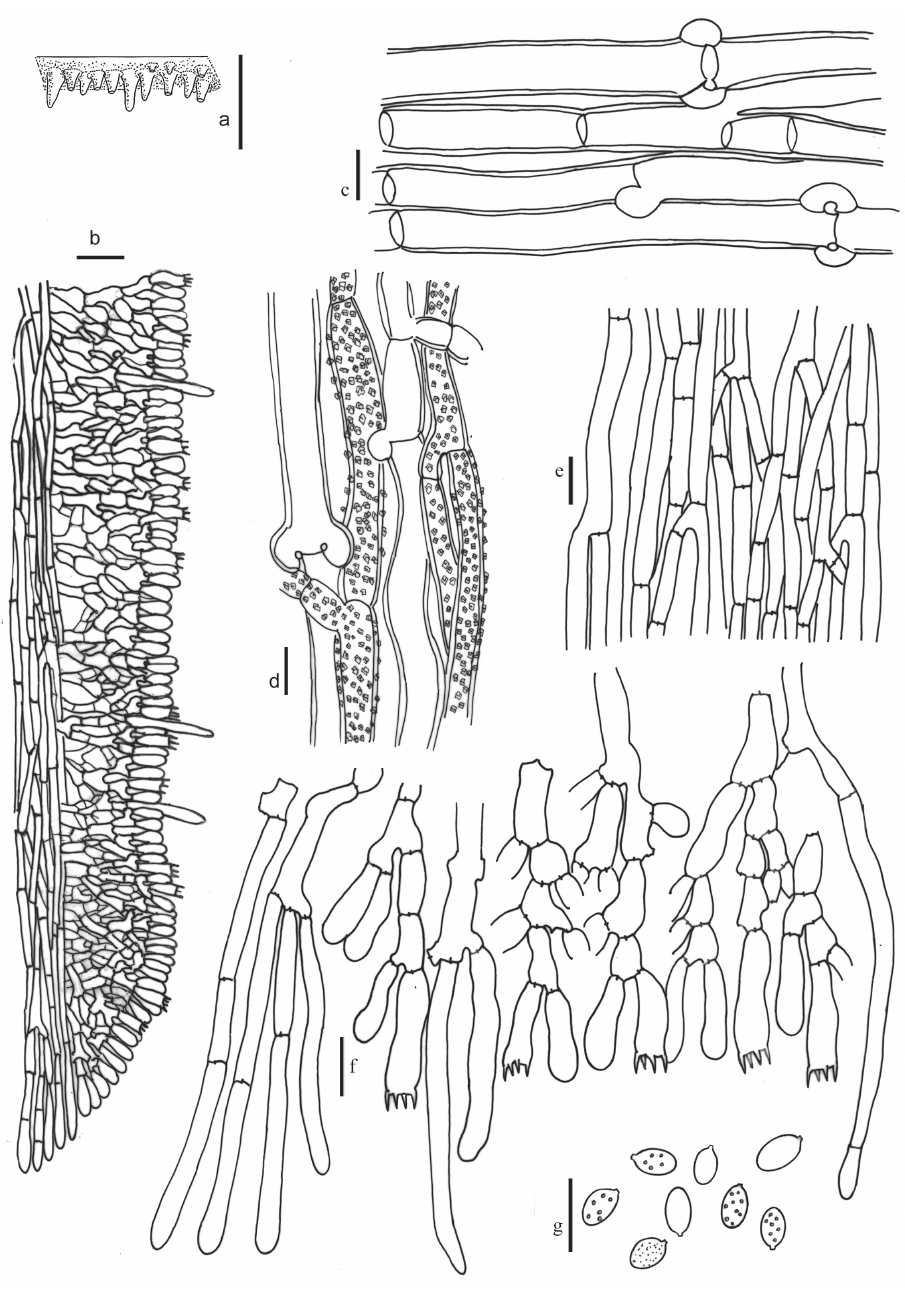
Figure 9. Hydnophlebia omnivora . Collection 5267 C.R. Shear coll., BPI, holotype a Hymenophore b Ver- tical section through an aculei c Subicular hyphae d Strand hyphae e Aculei hyphae f Subhymenial hyphae, cystidia, and basidia g Spores. Scale bars: a = 1 mm; b = 25 μm; c–g = 10 μm. Drawing by M.